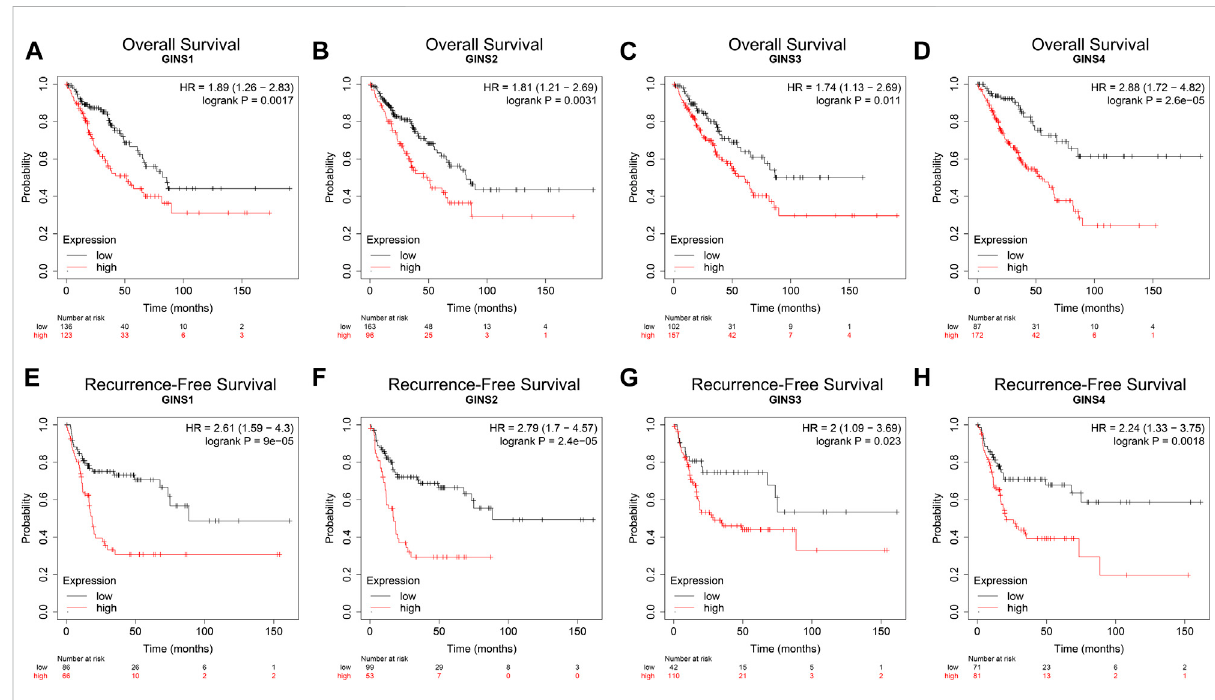
FIGURE 5 The prognostic value of GINS subunits in sarcoma patients (Kaplan – Meier Plotter). OS curves of GINS1/2/3/4 in SARC (A – D) . RFS curves of GINS1/2/3/4 in SARC (E – H) .